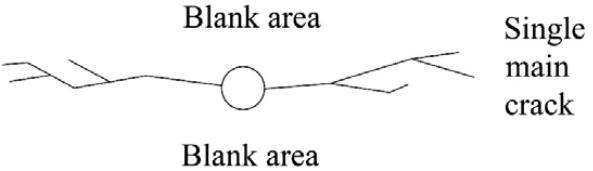
Figure 1. “Blank area” resulting from a single main crack propagation caused by ineffective cross ‐ measure hydraulic fracturing.